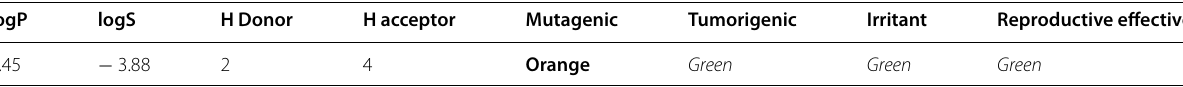
Green: Low risk (Drug conform behavior); Orange: Medium